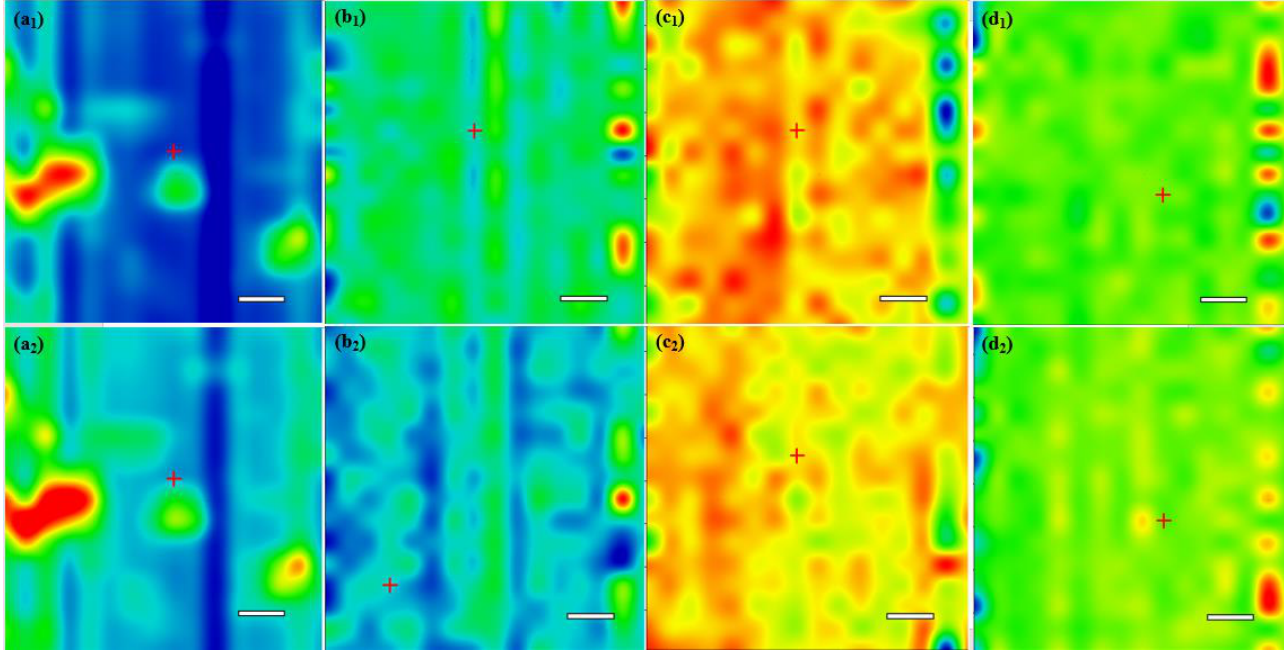
Figure 5. IRM of Fe 3 O 4 @CS drop-cast ( a ) and Fe 3 O 4 @CS thin coatings at 300 mJ/cm 2 ( b ), 400 mJ/cm 2 ( c ), and 500 mJ/cm 2 ( d ) based on the distribution of C-H (1) and C-N (2) bonds from CS; scale bar 100 µ m. Similar observations were made by comparing the IRM of the Fe 3 O 4 @CS/LyZ coatings (Figure 6).